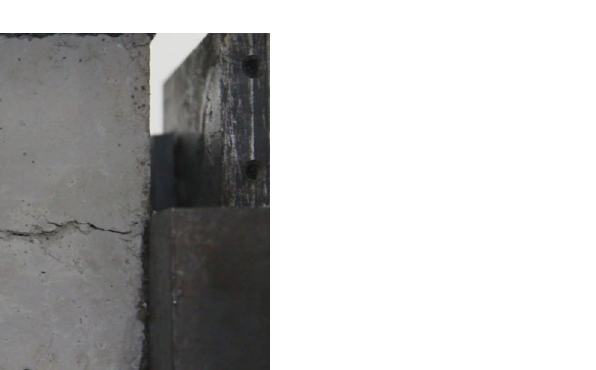
Figure 60. Photograph showing penetration patterns of the tip of the left crack and the tip of the right crack are directly connected.